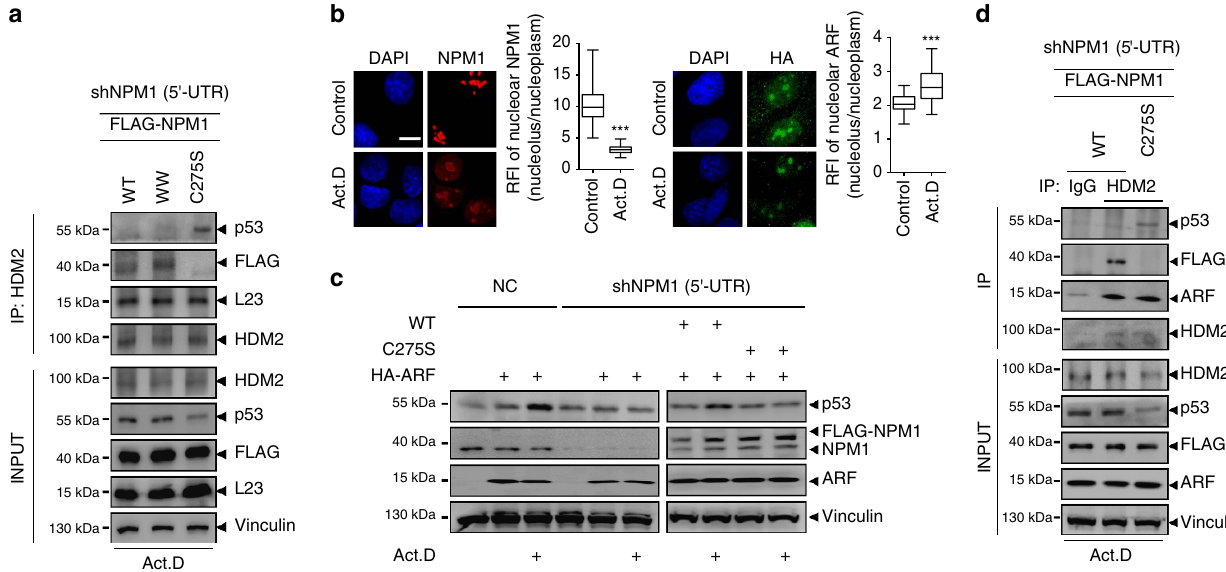
Figure 8 | The presence of nucleoplasmic NPM1 is a prerequisite for stress-induced p53 activation. ( a ) FLAG-NPM1 WT and the mutants WW and C275S were added back to NPM1-silenced cells before treatment with Act.D. Co-IP assays were performed using antibody against HDM2 and western blottings were performed using antibodies as indicated. ( b ) Localization of exogenous HA-ARF and endogenous NPM1 after Act.D treatment, from respective cells on same coverslip. Nucleolar/nucleoplasmic RFI ratio of NPM1 ( n ¼ 29) and ARF ( n ¼ 41) were displayed. Mean ± s.e.m. Unpaired t -test. *** P o 0.001. ( c ) p53 accumulation in HA-ARF-transfected normal and NPM1-silenced cells (left) or in FLAG-NPM1 WTor the mutant C275S added back NPM1-silenced cells (right), with or without Act.D treatment as indicated. ( d ) HA-ARF was co-transfected with FLAG-NPM1 WTor the mutant C275S in NPM1-silenced cells before treatment with Act.D. Co-IP assays were performed using IgG or antibody against HDM2, and western blottings were performed using antibodies as indicated. Scale bars, 10 m m. WW, W280/290A. All of the experiments were performed in U2OS cells.